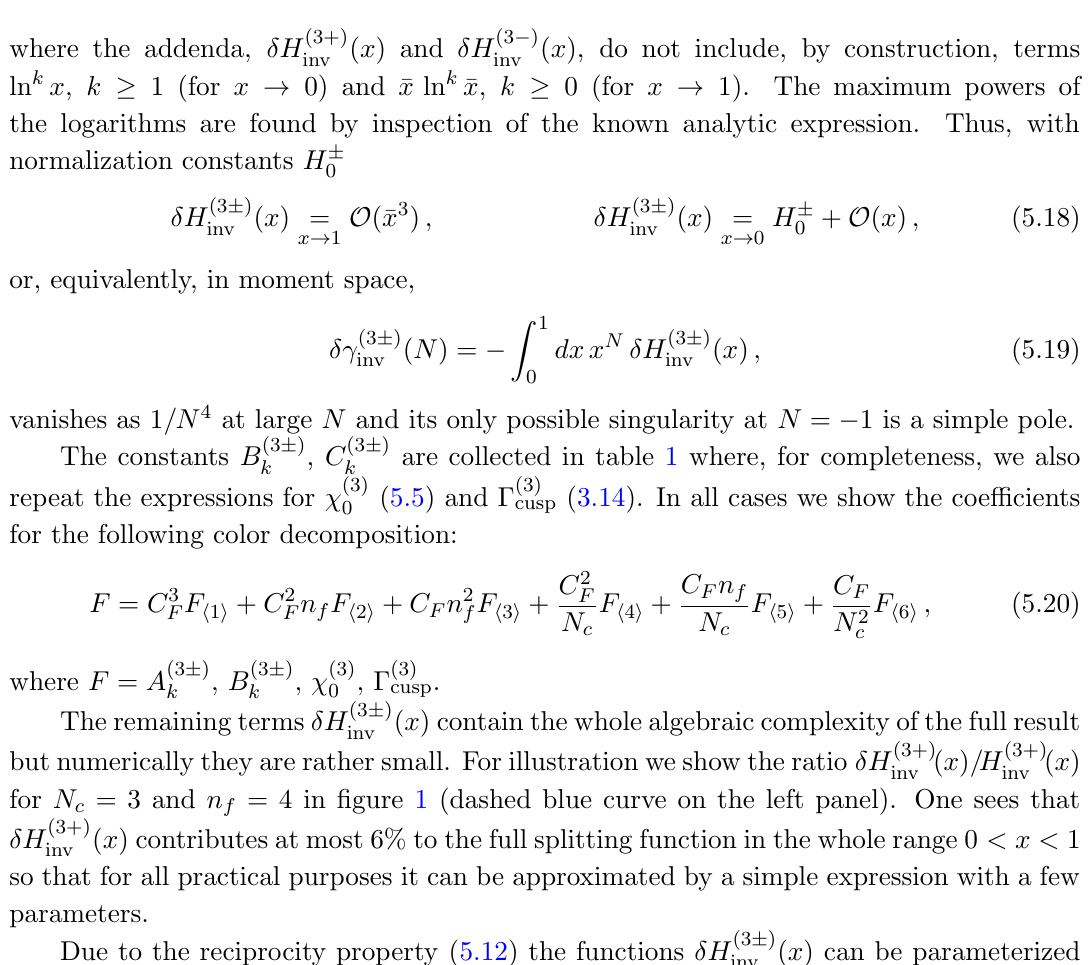
Figure 1 . Left panel shows the ratio (cid:14)H (3+) tions and the error in using the approximation (5.22) , ( (cid:14)H (3+) curve) for n f = 4. The shaded area indicates an error band of 0 : 5%. The similarly de(cid:12)ned approx- imation error for the combinations H (+) + H ( (cid:0) ) (dashes) and H (+) (cid:0) H ( (cid:0) ) (solid) which give rise to moments with odd and even N , respectively, is shown on the right